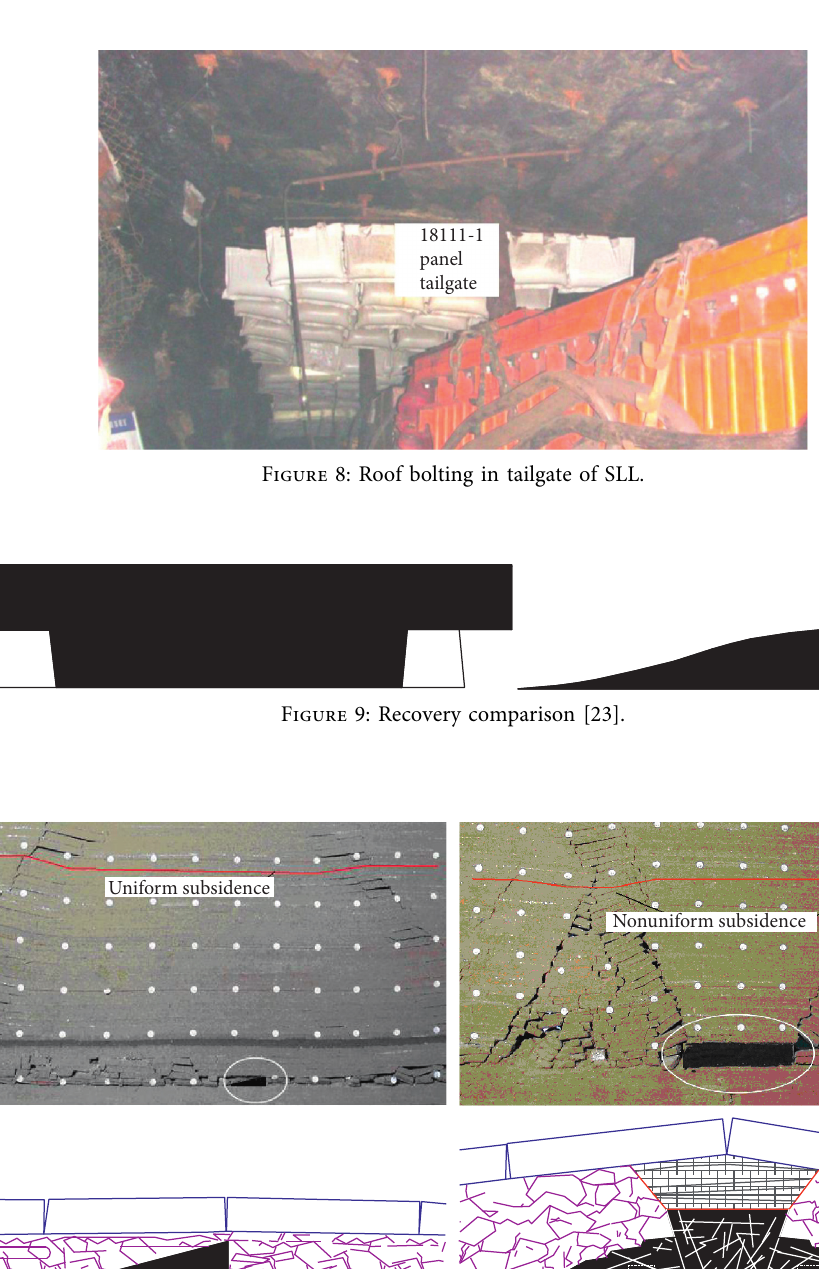
Figure 7: Stress distribution due to extraction of one SLL panel.